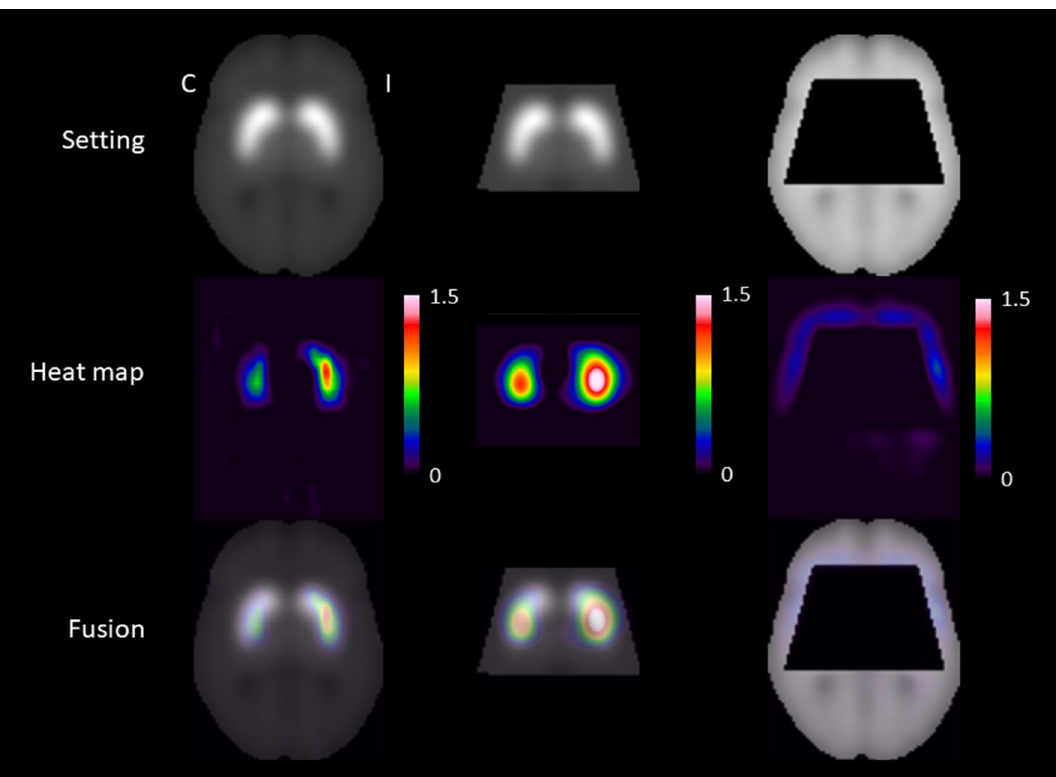
Figure 2. Mean heat maps through the striatum. Transversal slice through the striatum of the mean heat maps (middle row) of the correctly classified 123 I-FP-CIT SPECT images in the three different settings (“full image”: left column, ”striatum only”: middle column, “without striatum”: right column). The mean heat maps were obtained by voxel-wise subtraction of the mean relevance map of the 123 I-FP-CIT SPECT images correctly classified as reduced and the mean relevance map of the 123 I-FP-CIT SPECT images correctly classified as normal by the CNN (Fig. 1) ( C contralateral, I